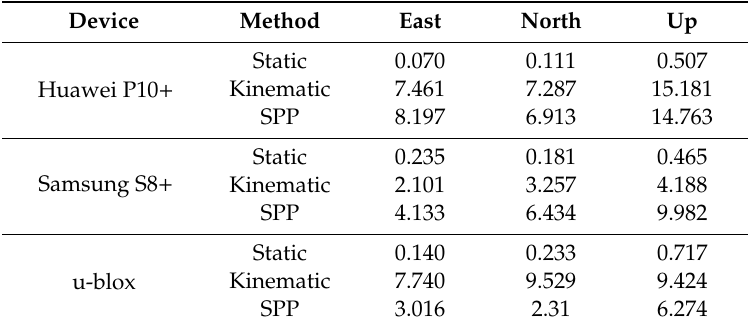
Table 6. Accuracy results of Huawei P10 + , Samsung S8 + , and u-blox for a session length of 10 min. All results exceeding a threshold of 3 m are highlighted inside the table.